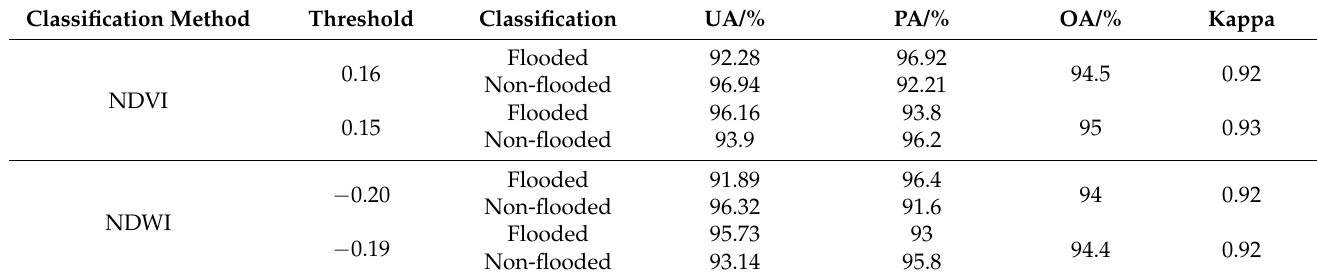
Table 5. Flood mapping with NDVI and NDWI accuracy assessment results on the Sentinel-2 image. Classification